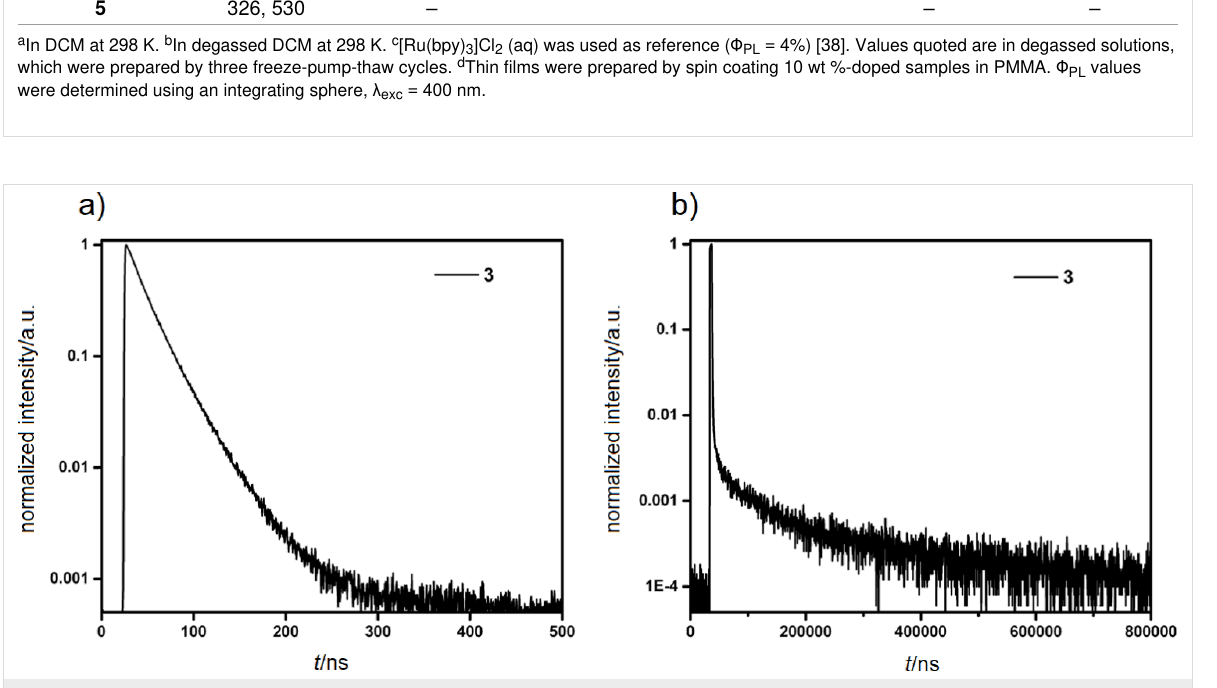
and thin film. While compounds 2 , 4 , and 5 were very poorly emissive, 3 showed a green emission with a biexponential life- time characterized by a prompt nanosecond component and a delayed component of 353 μ s, indicative of a TADF